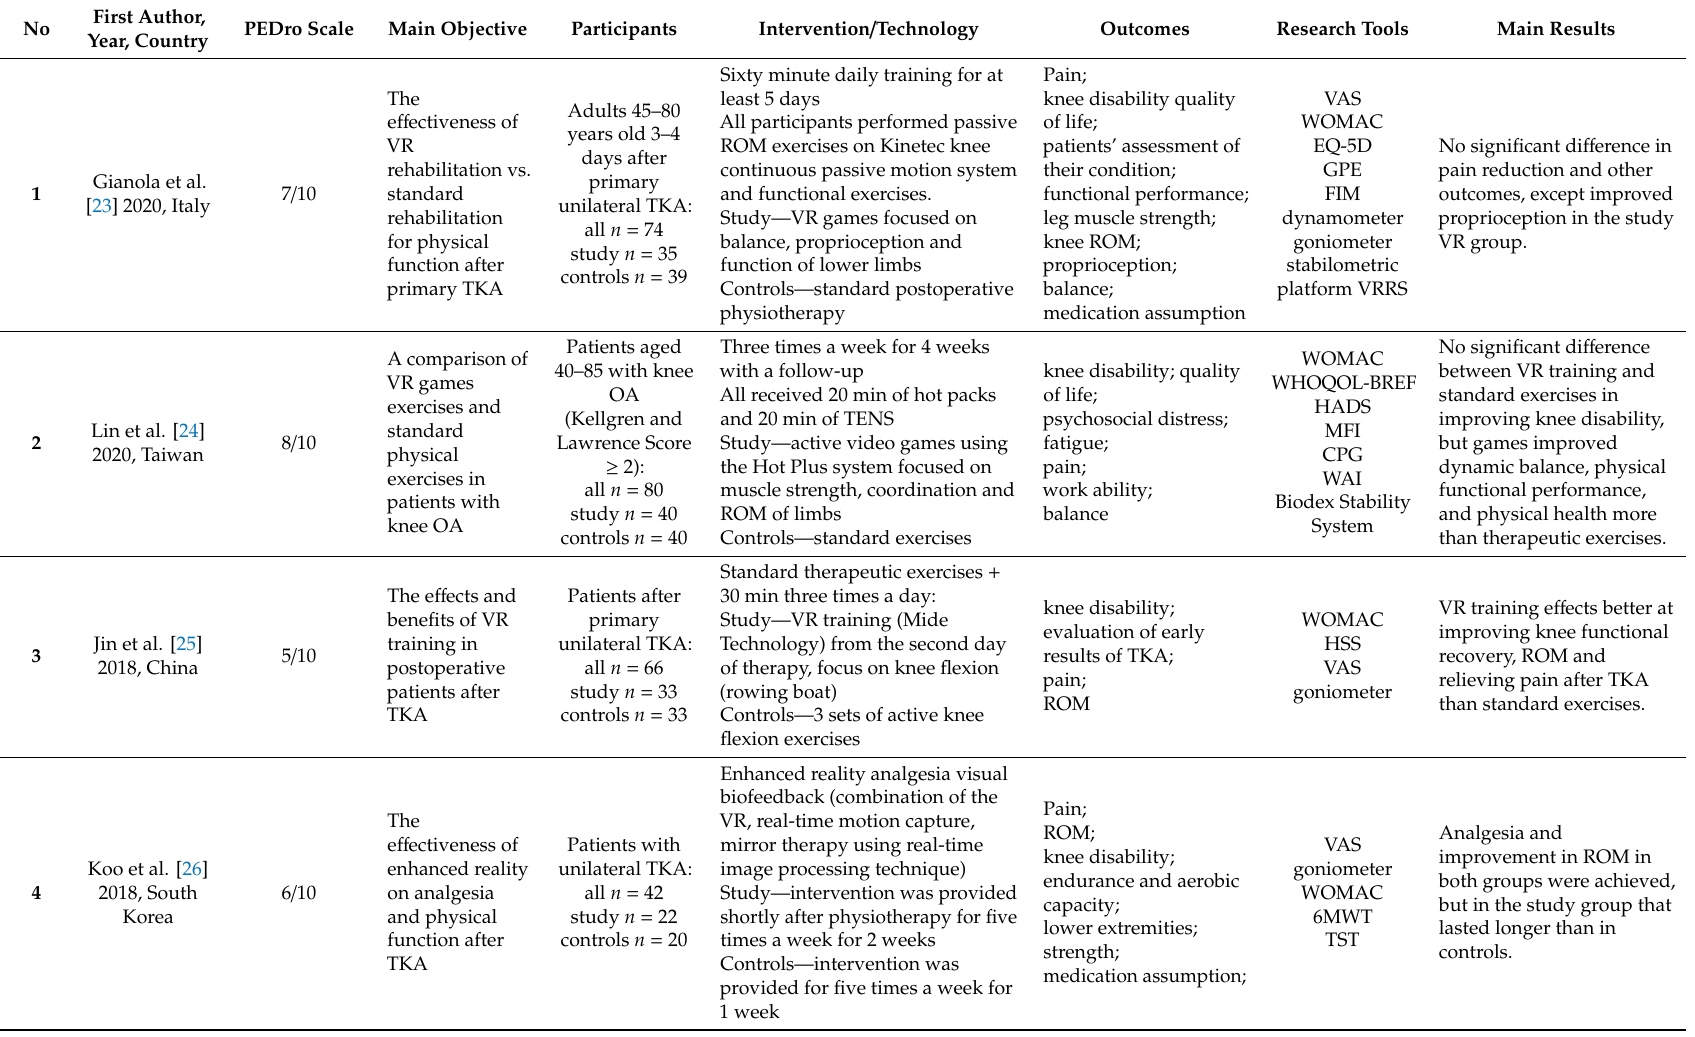
Table 1. Characteristics of the included